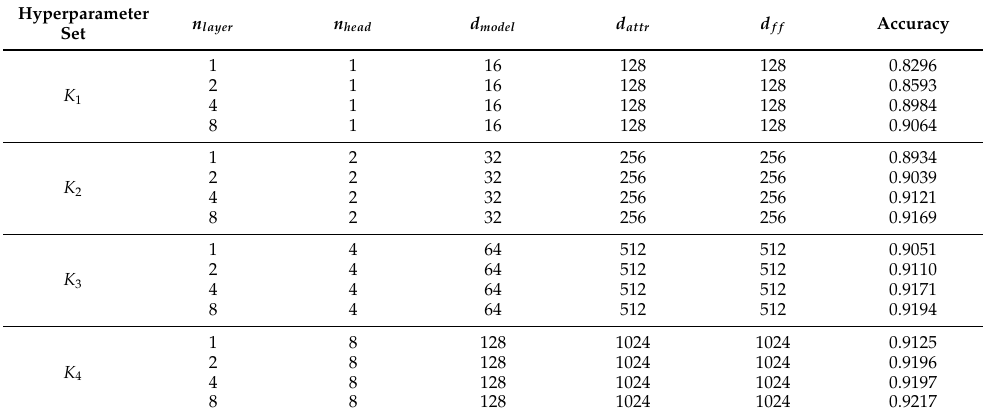
Table 6. Experiment results according to the hyperparameter